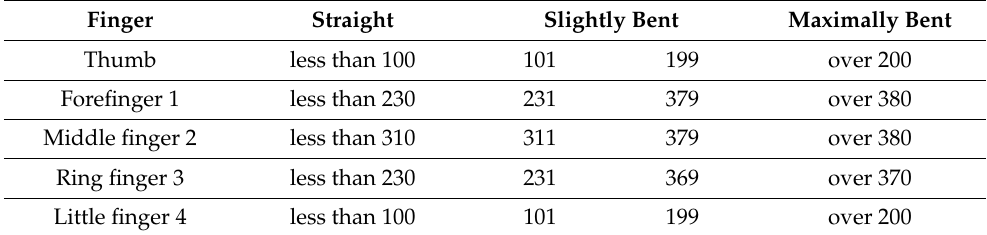
Table 3. Range of digital signal values for every bend